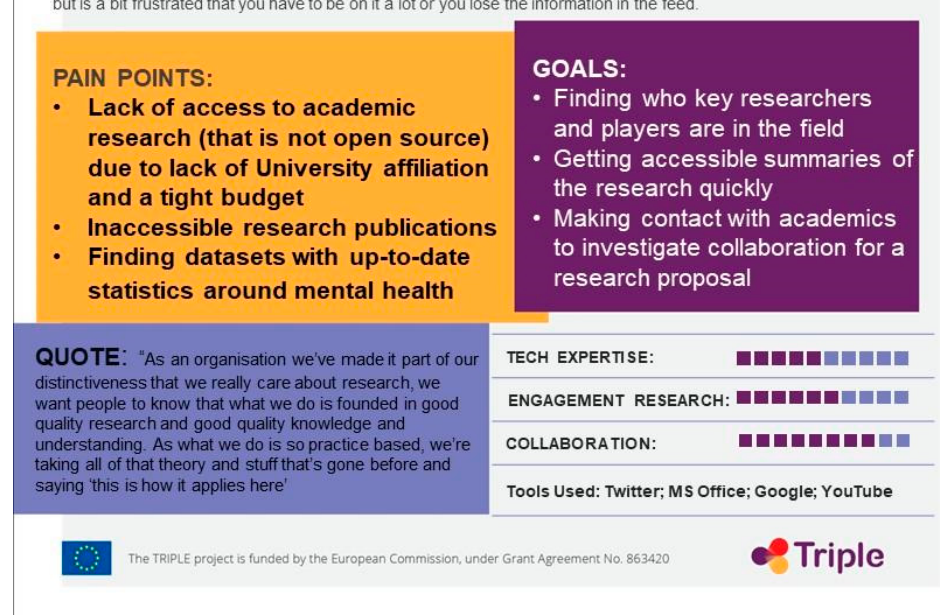
Figure 4. Example of a non-academic persona created from the results of the qualitative interviews and subsequent thematic analysis.